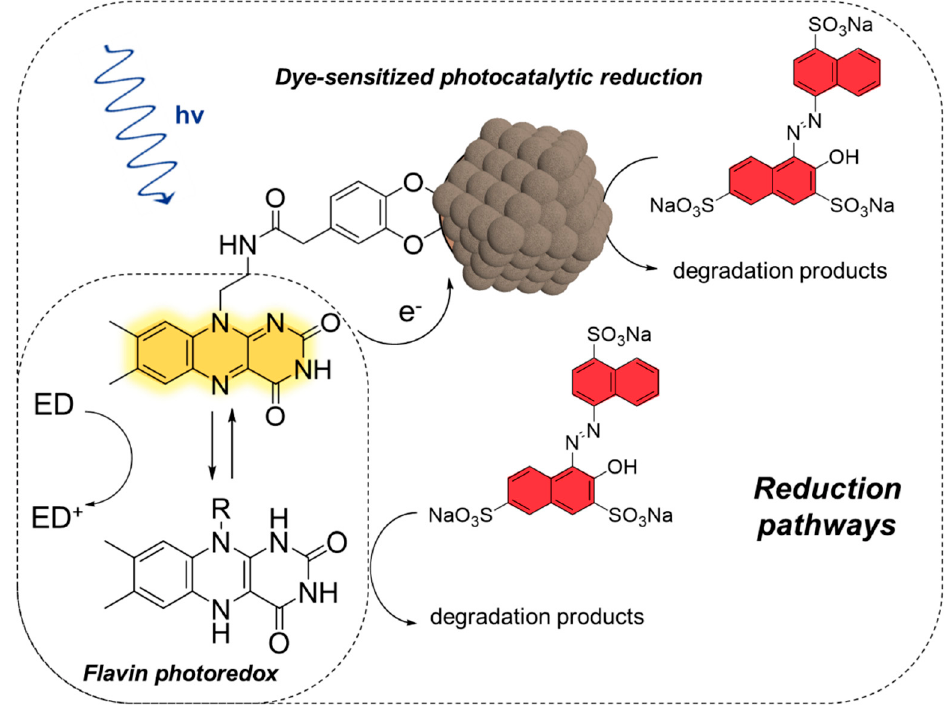
Figure 4. ( A ) The relative concentration of remaining AMT in solution (C/C 0 ) measured using UV-vis absorption spectroscopy ( λ max = 520 nm) after irradiation with 450 nm blue light for 3 h in the presence of (A) IONP or (B) IONP-DAFL and MES under an O 2 atmosphere with (2,2,6,6-tetramethylpiperidin-1-yl)oxidanyl (TEMPO), 1,4-diazabicyclo [2.2.2]octane (DABCO) and mannitol as reactive oxygen species (ROS)